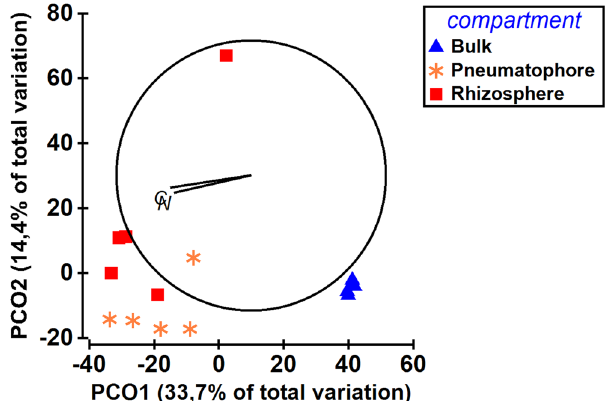
Figure 4. Clustering pattern of fungal community composition in bulk, pneumatophore and rhizosphere soil compartments. The C and N in the figure indicate the carbon and nitrogen content of the different soil compartments, respectively. The significant correlation was observed between fungal community composition and carbon or nitrogen content of the soil compartments. OTUs were clustered at 97% similarity level. The weighted and constrained principal-coordinate analysis (PCoA) based on Bray–Curtis dissimilarity on standardized and square-root transformed data was performed in PRIMER software